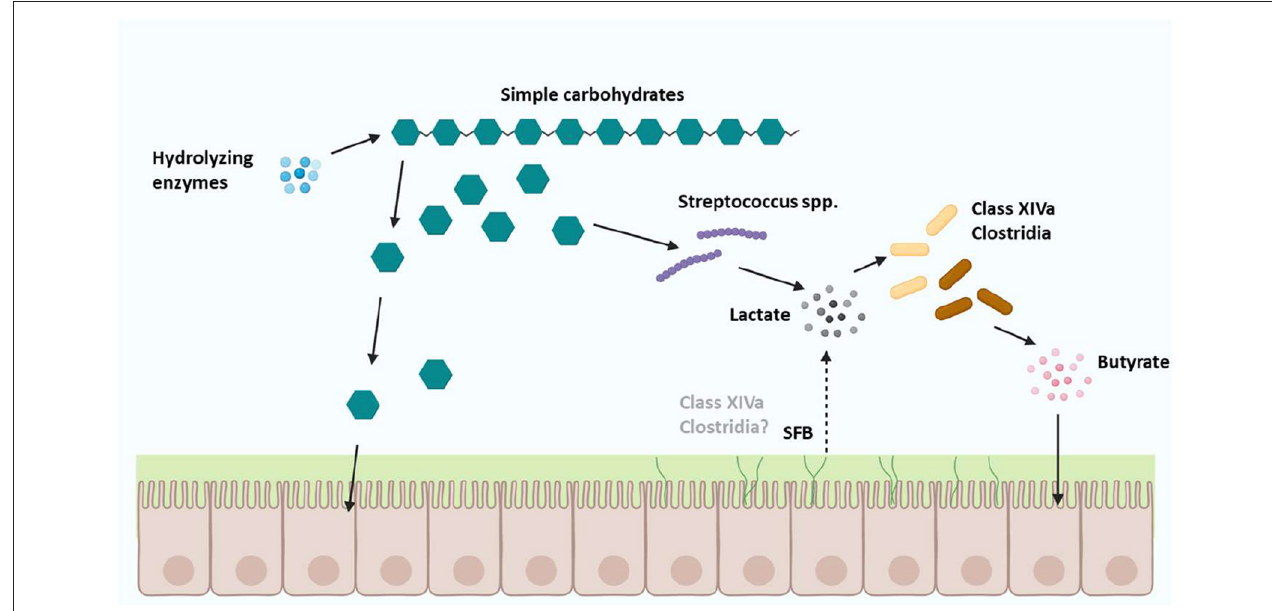
FIGURE 4 | Cross-feeding of carbohydrate substrates between Clostridium class XIVa microbes and other Firmicutes. Cross-feeding with microbes from Clostridium class XIVa, and the Firmicutes phylum (42) might include SFB which are proposed to be a separate genus of Clostridia, based on a small number of SFB orthologs identified in host-associated Clostridia [Figure adapted with permission from Zoetendal et al. (4); Created with BioRender.com].